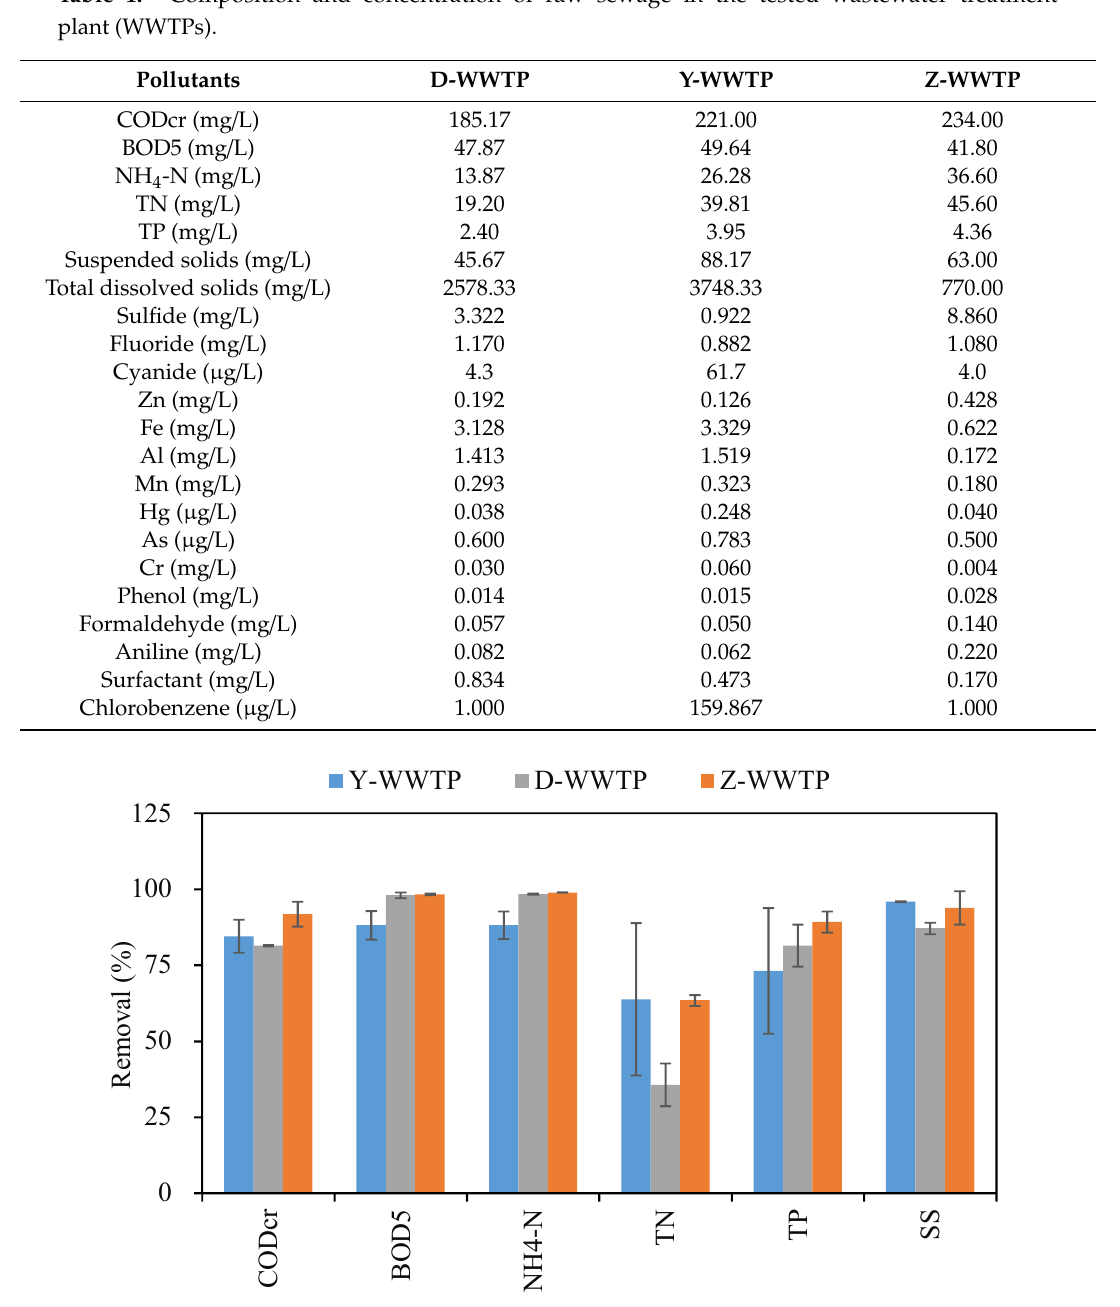
Figure 1. Removal e ffi ciencies of the conventional pollutants in Y-, D-, and Z-wastewater Figure 1. Removal efficiencies of the conventional pollutants in Y-, D-, and Z-wastewater treatment treatment plants.